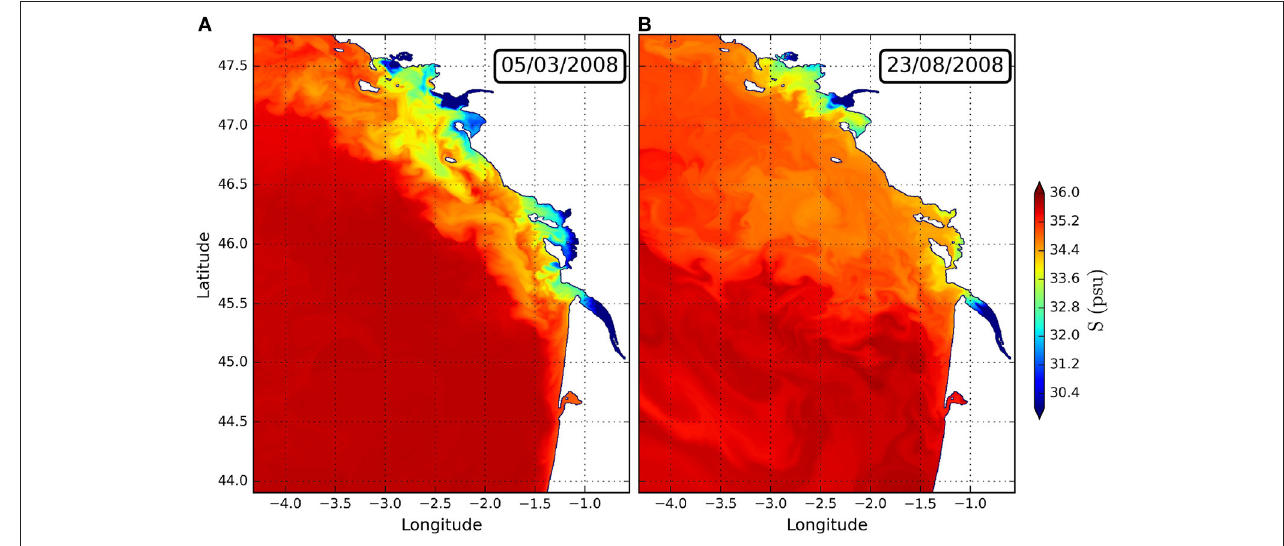
FIGURE 2 | Modeled sea surface salinity at midnight on March 5 (A) and on August 23 (B)